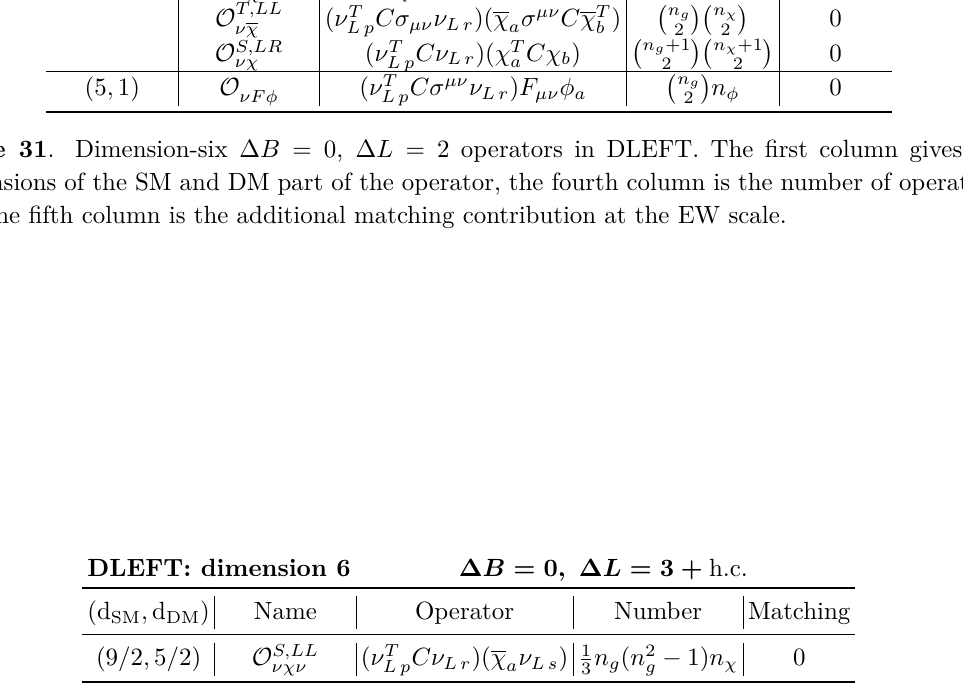
Table 32 . Dimension-six ∆ B = 0 , ∆ L = 3 operator in DLEFT. The first column gives the dimensions of the SM and DM part of the operator, the fourth column is the number of operators, and the fifth column is the additional matching contribution at the EW